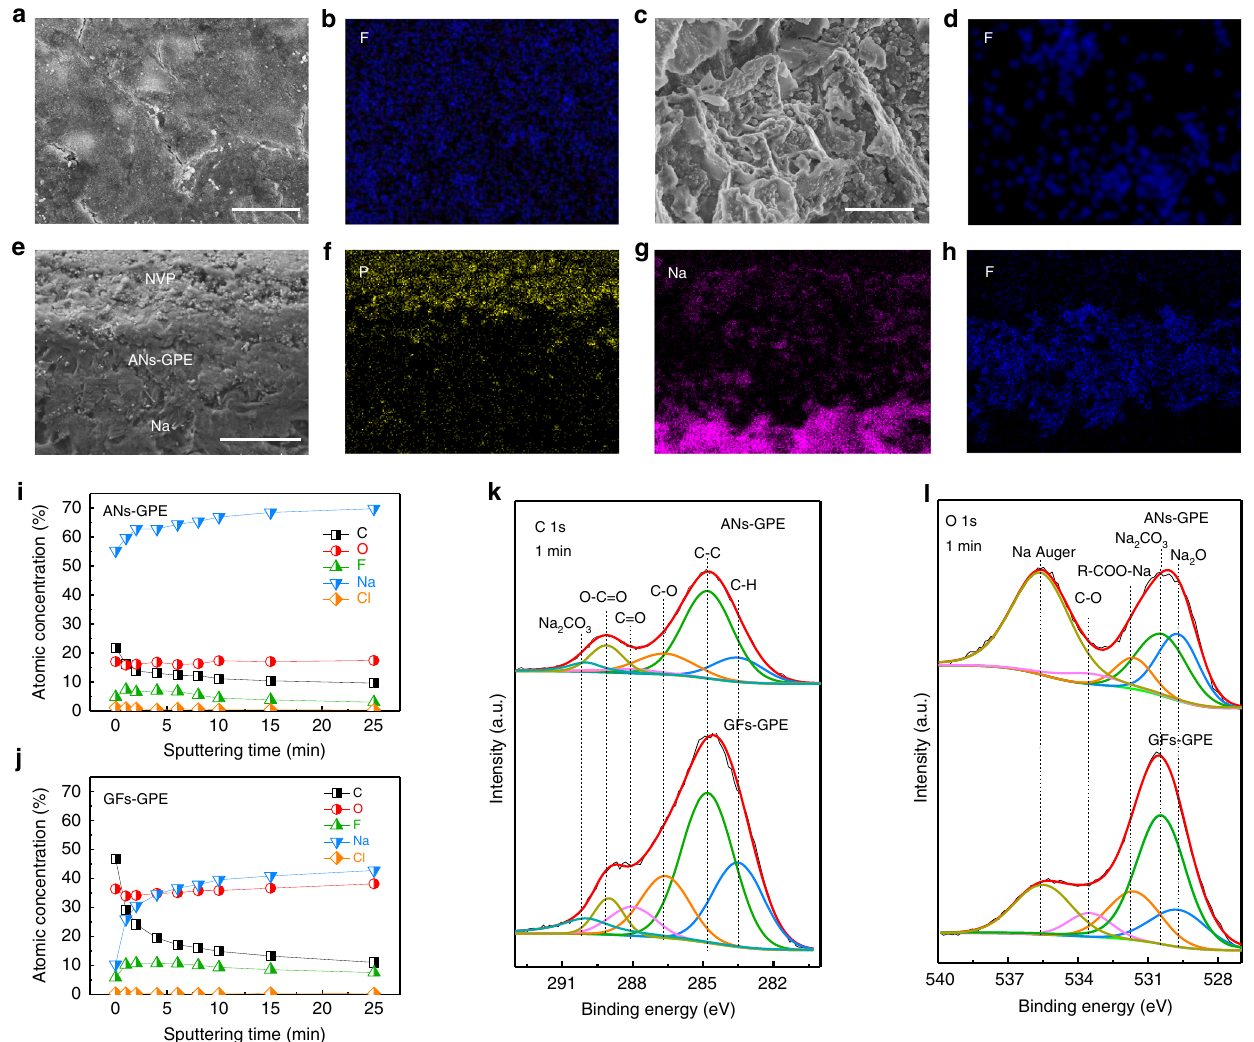
Fig. 6 Morphology and components analysis of the Na metal anode after cycling at 1 C using ANs – GPE and GFs – GPE at 60 °C. a – d SEM and EDS images of the Na metal anode surface after 200 cycles. e – h SEM and EDS images of cross-section of the NVP/ANs – GPE/Na cell after 1000 cycles. i, j Atomic concentration of various elements with sputtering time. k , l High-resolution C1s and O1s XPS spectra of Na anodes after 200 cycles. Scale bars, 5 μ m in a , c ; and 50 μ m in